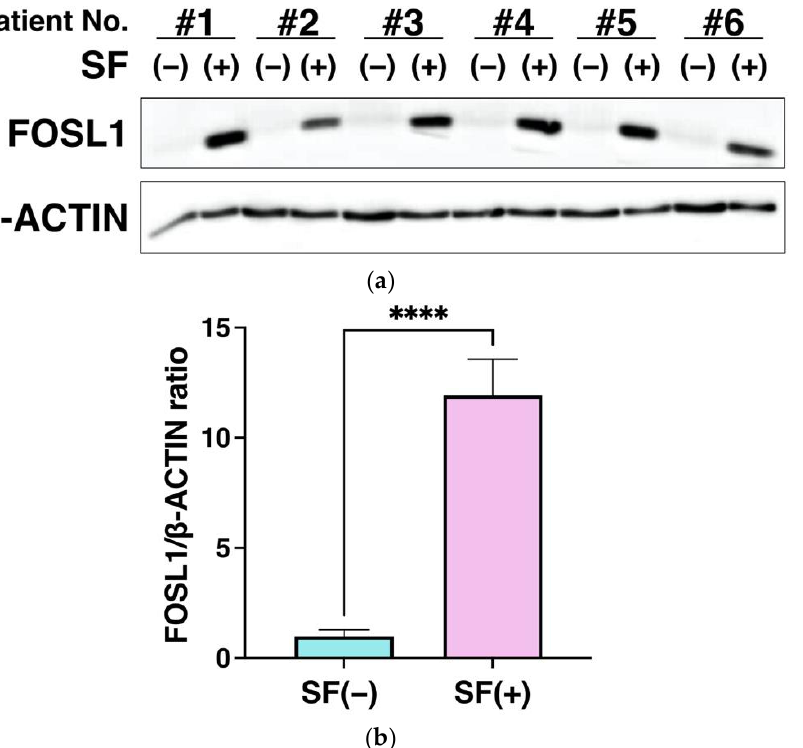
Figure 5. Validation of increased FOSL1 protein expression using western blot analysis. ( a ) Western blot analysis of FOSL1 protein expression. Six SF samples were used to analyze FOSL1 protein levels in the ADSCs. ( b ) FOSL1 expression was quantitated from the bands. Protein expression was normalized to the expression of β -ACTIN and calculated as the relative expression ratio of the group with 20% SF to the untreated group ( n = 6). Data are expressed as the mean ± S.D. **** p < 0.0001 is shown.